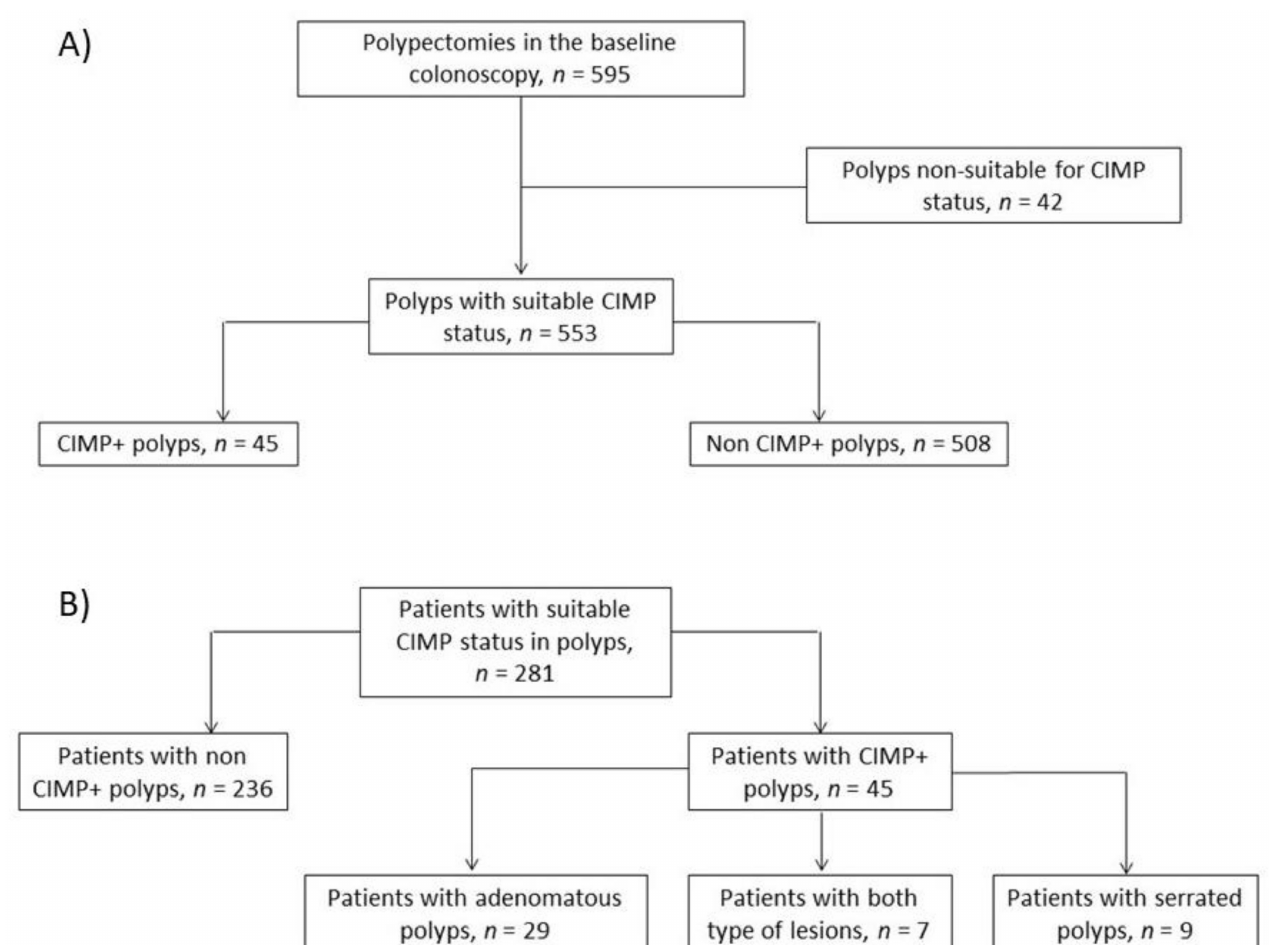
Figure 1. Study flow charts. ( A ) Flow chart of polyps removed at baseline colonoscopy. ( B ) Flow chart of the study population according to the genetic profile of polyps at